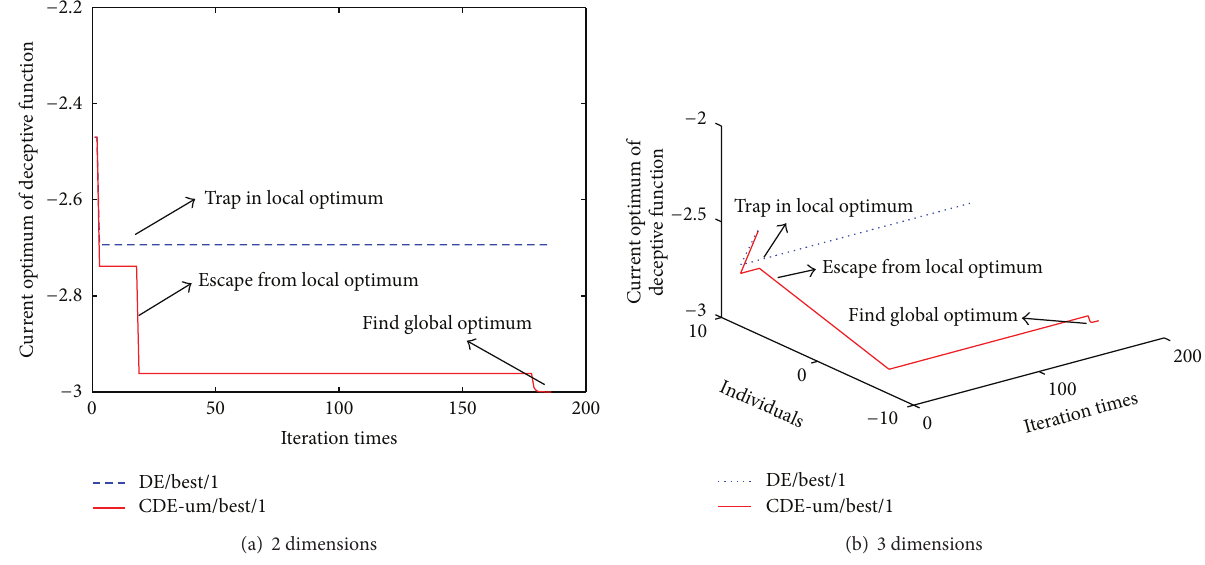
Figure 5: Convergence graph for DE’s deceptive function at a